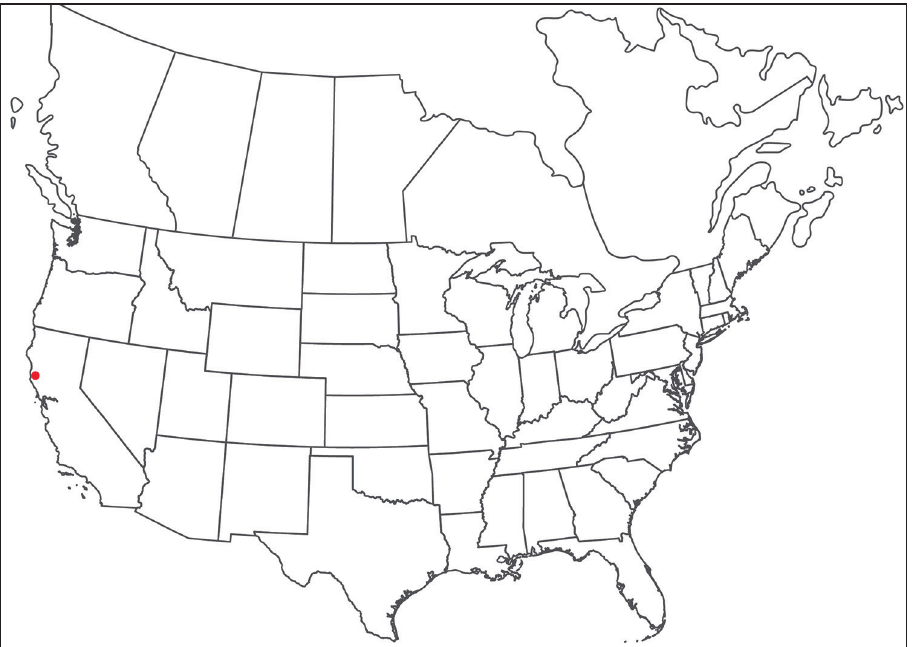
Figure 129. Torrenticola leviathan sp. n.